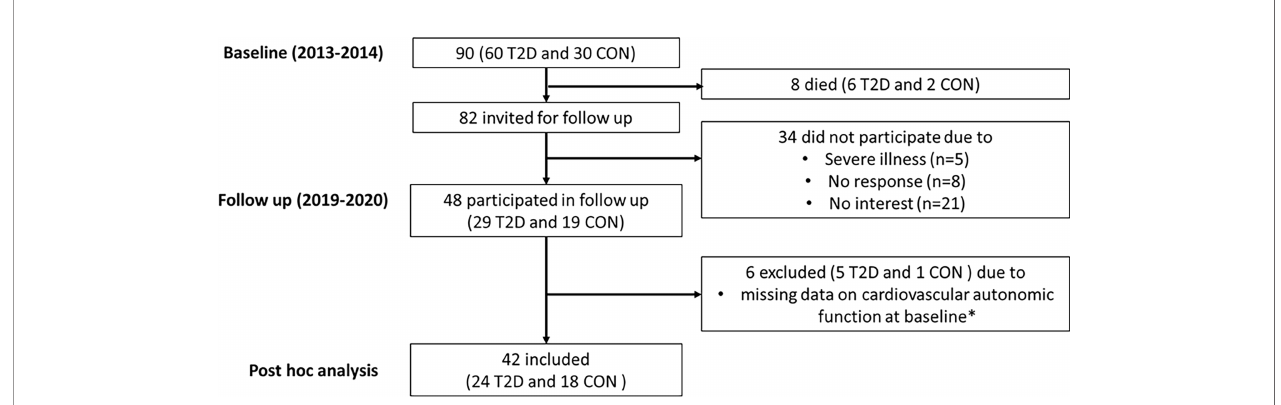
FIGURE 1 | Flowchart for participants. T2D, Type 2 diabetes; CON, Healthy control. *Due to lack of compliance or malfunction of the equipment at the time